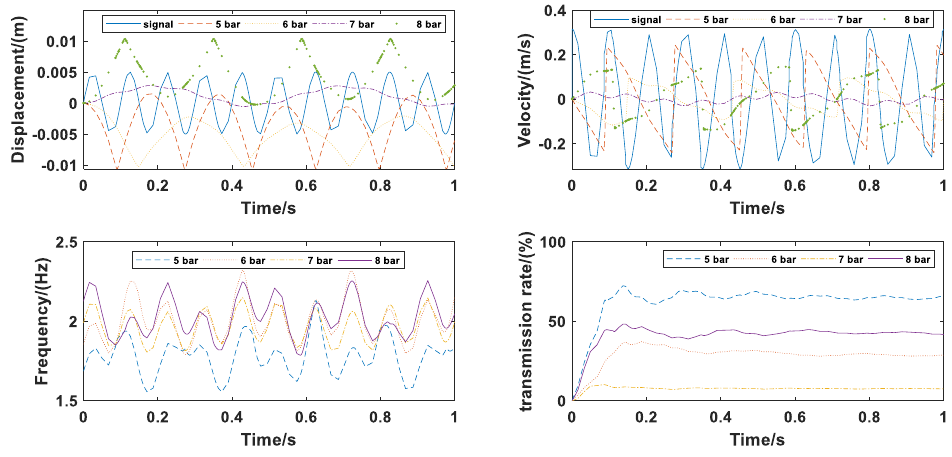
Figure 7. Simulation results under 10 Hz, with 5 mm amplitude vibration.